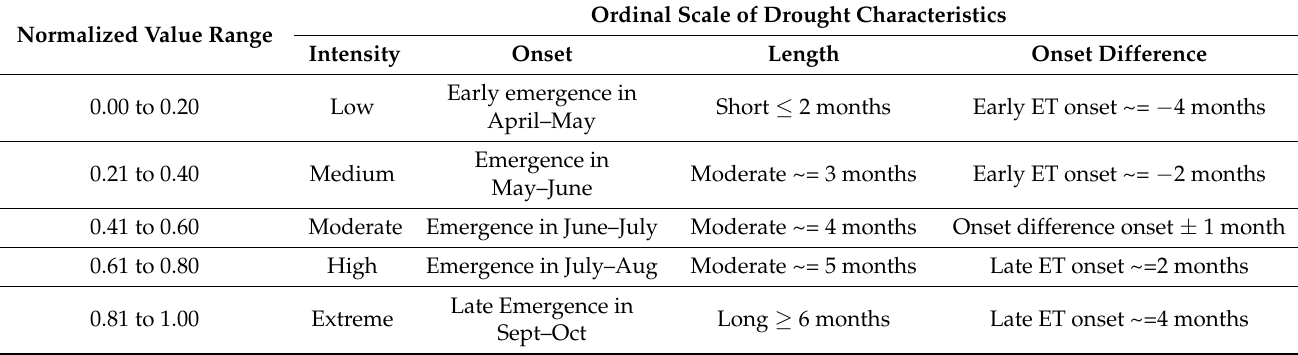
Table 1. Relation of normalized value ranges and ordinal scale of drought